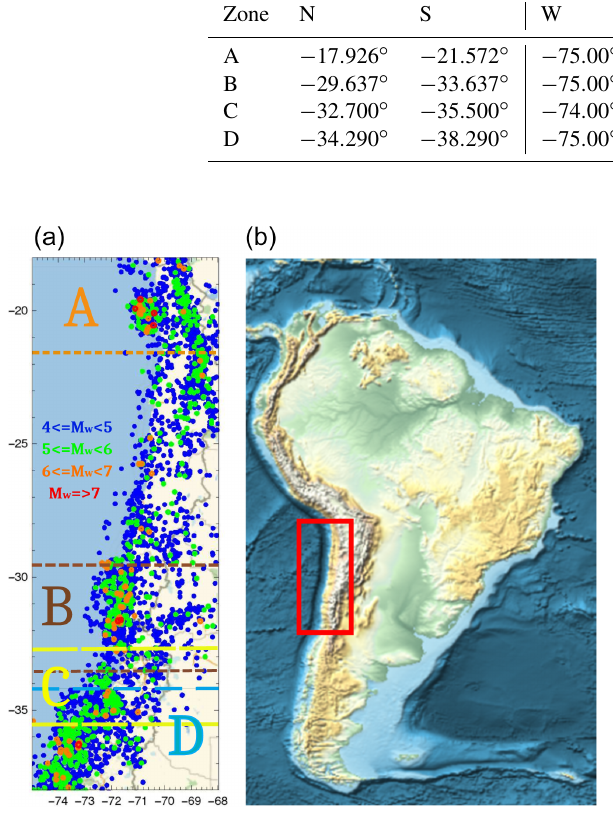
Figure 1. (a) Map showing the seismic events with magnitudes greater than M w 4.0 and the division in four geographical zones A, B, C and D defined in Table 1. The seismic events are shown by circles using the following color code according to magnitude: between 4.0 and 4.9 in blue, between 5.0 and 5.9 in green, between 6.0 and 6.9 in orange, and for a magnitude equal to or greater than M w 7.0 in red. (b) Map of South America showing with a red rect- angle the area displayed in the figure to the left. The trench between the South American plate and the Nazca plate appears in dark